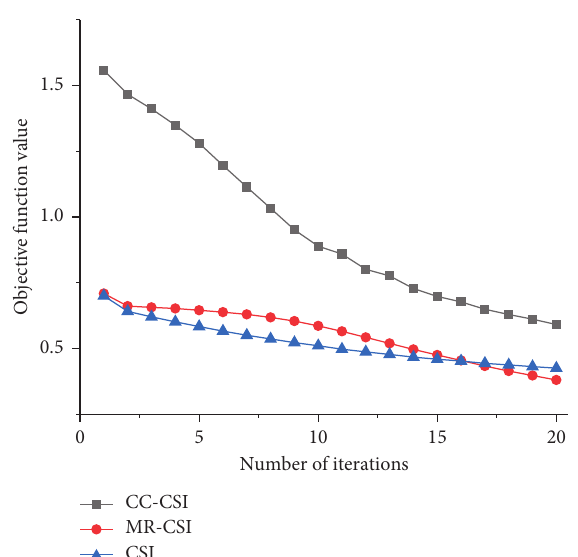
Figure 9: The objective function values of the scatterer (TE